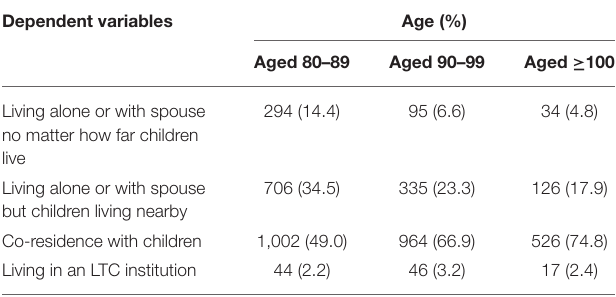
TABLE 2 | Anticipated living arrangement categorized based on the age